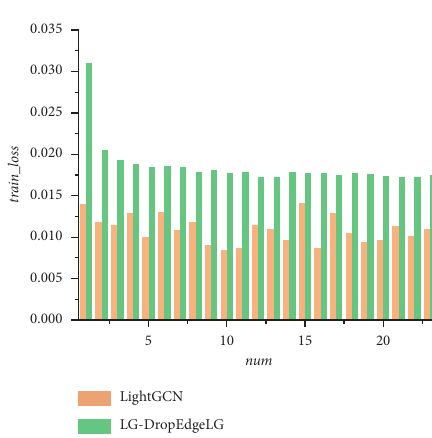
Figure 2: Train_loss comparison at the same ndcg level (Gowalla).